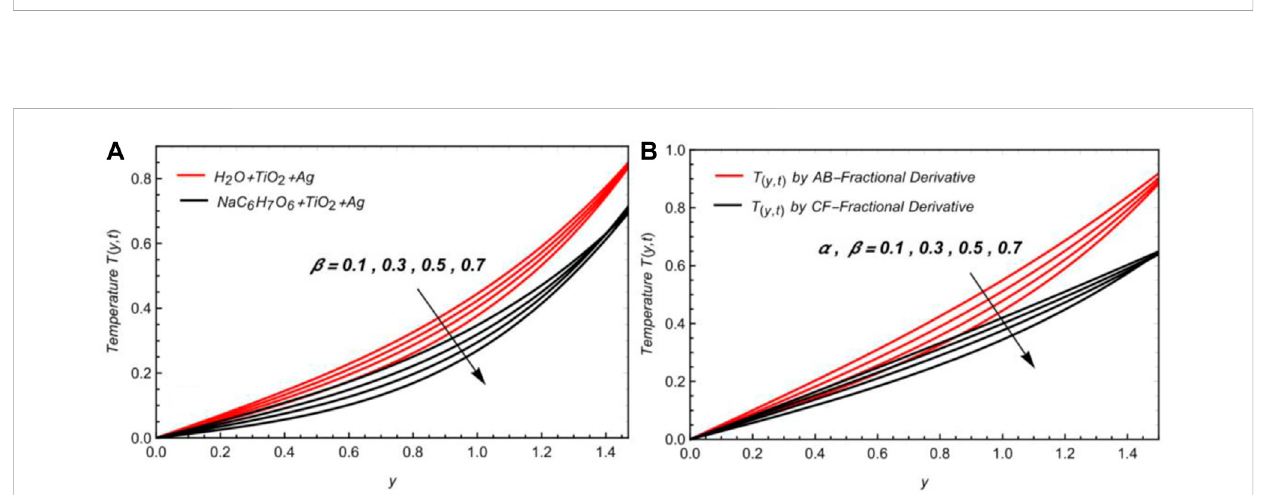
FIGURE 3 T ( y , t ) due to variation in fractional parameters with φ (cid:2) 0 . 02and t (cid:2) 0 . 8.